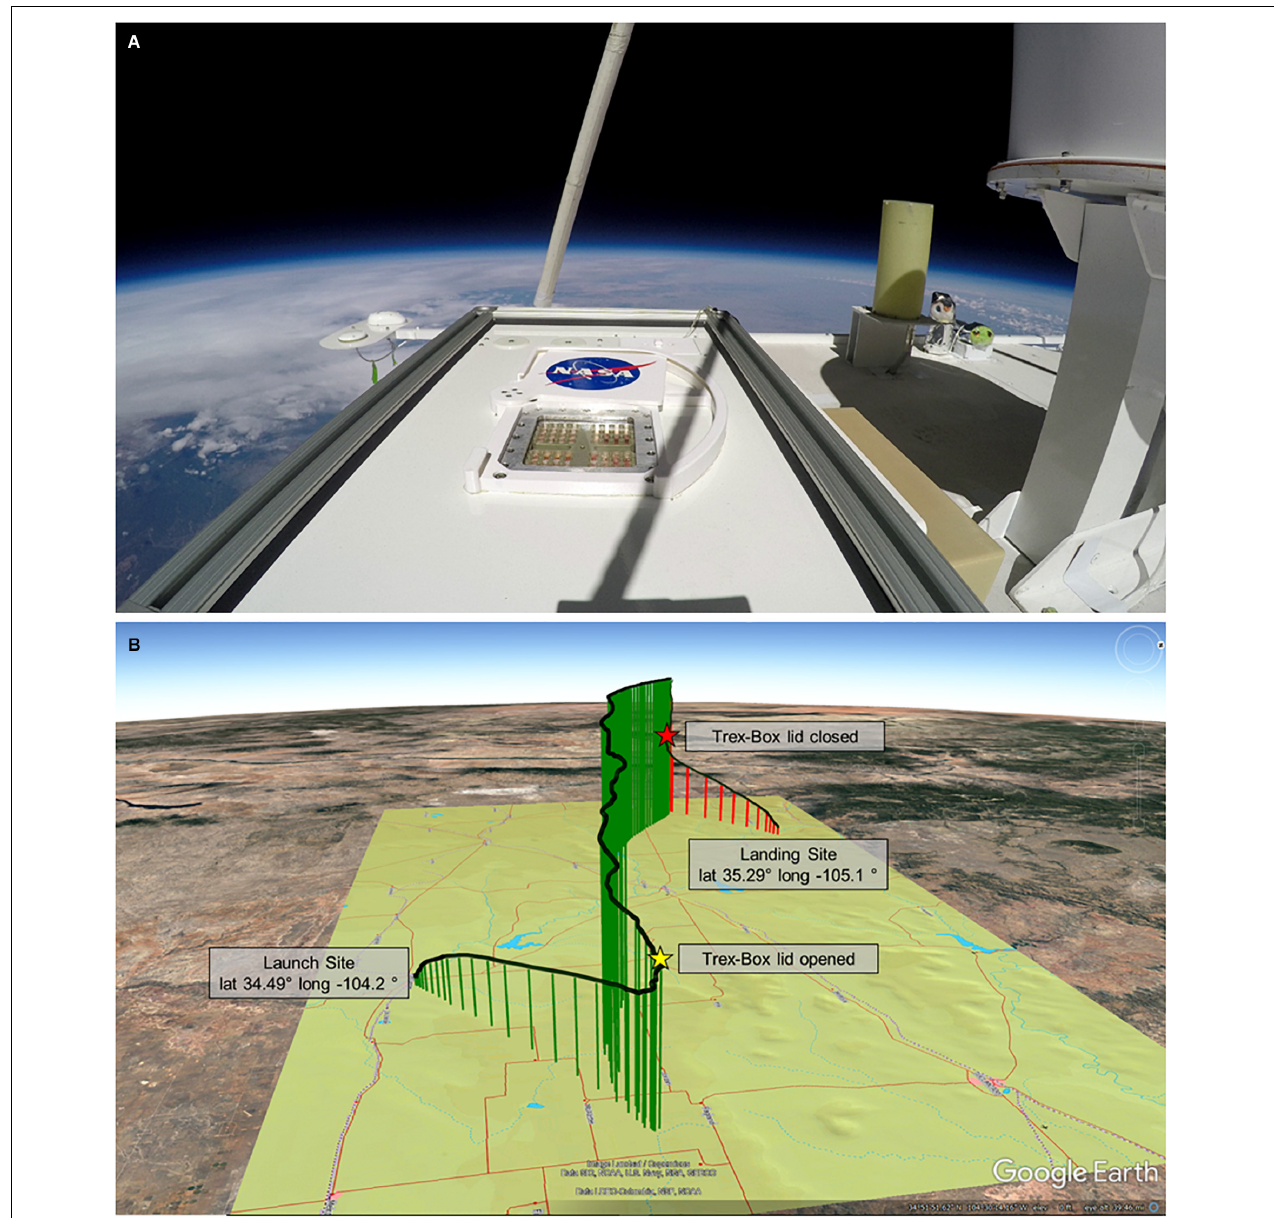
FIGURE 4 | Balloon flight (A) Image from atop the MARSBOx payload and Trex-Box in the stratosphere during the flight. (B) Balloon flight path; stars mark opening and closing of the Trex-Box lid, which corresponds to UV-VIS radiation exposure beginning and